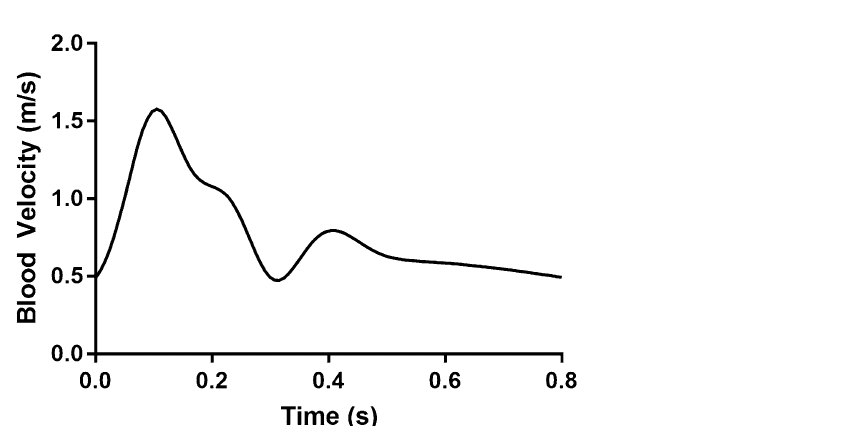
Figure 3. Velocity function for the arterial